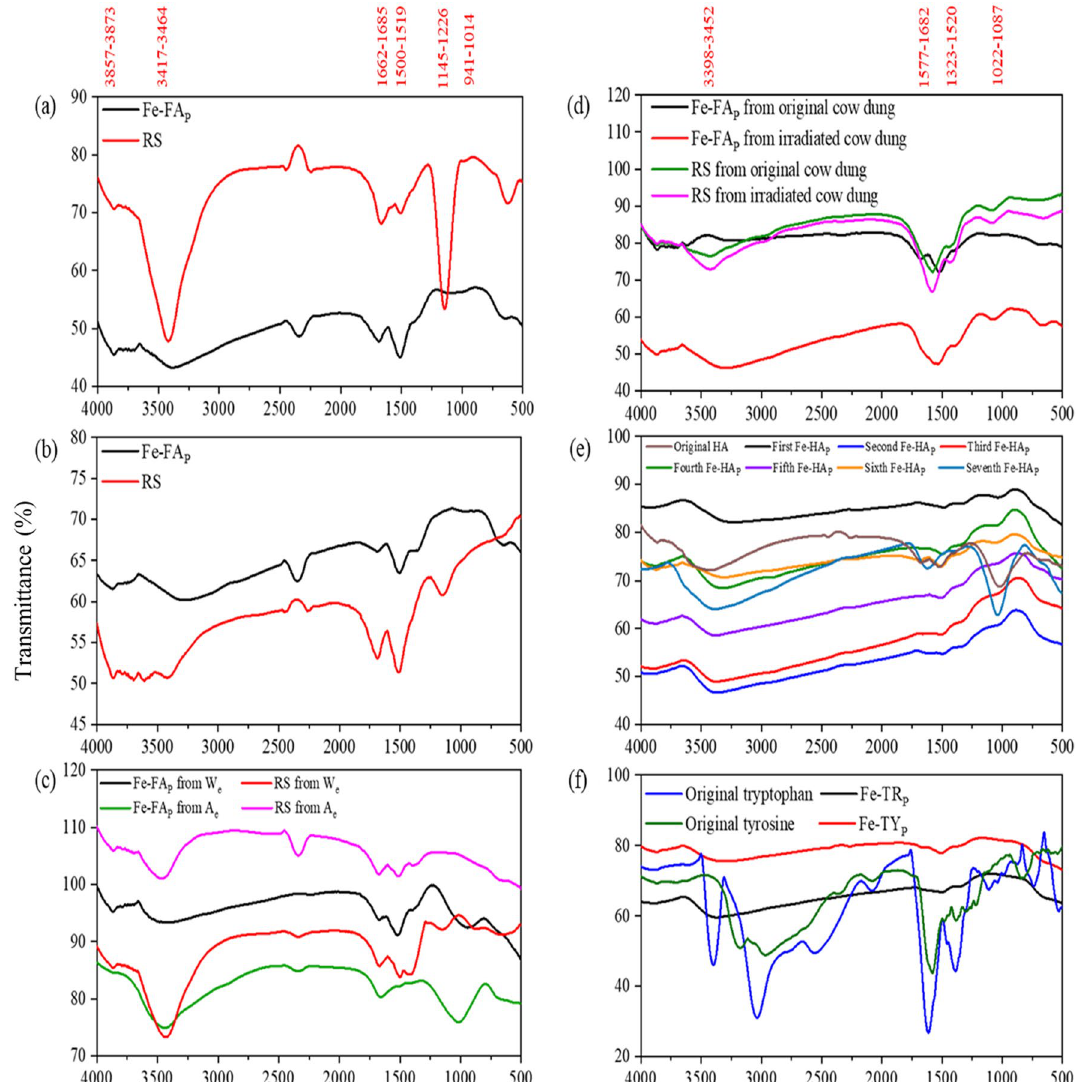
Figure 4. FTIR spectra of Fe ‒ fulvic acid precipitates (Fe ‒ FA P ) and remaining solution (RS) after the final precipitation step of Fe ‒ FA P from Baigou River ( a ), Jingye Lake ( b ), soil We and Ae ( c ), original and irradiated cow dung samples ( d ), original soil humic acids (HA) and Fe ‒ HA precipitates (Fe ‒ HA P ) ( e ), and Tryptophan (TR) and Tyrosine (TY) and their FeCl 3 precipitates (Fe ‒ TR P and Fe ‒ TY P ) ( f The N% features the lowest values in Fe-FA P from river, lake and soil W e and the highest ones in the original HA and Fe-FA P from cow dung, whereas in Fe-FA P from irradiated cow dung sample, Fe-HA P , Fe-Tryptophan P and Fe-Tyrosine P the N% is lower than that in the corresponding unreacted sample. The high N% in the original cow dung sample may be attributed to the high content of Tyrosine 65 that declines upon sunlight exposure of cow dung. The C/N ratio is relatively low in Fe-FA P from soil A e , and much higher in irradiated cow dung, Fe-HA P , Fe-Tryptophan P and Fe-Tyrosine P than in the corresponding not-irradiated cow dung, soil HA, Tryptophan and Tyrosine. Finally, the S% results ≤ 1.0% in most Fe-FA P samples and only in the Fe 3+ precipitate from irradiated cow dung sample reaches the maximum value of 1.0%. As expected from the corresponding S%, the C/S ratios of Fe-FA P from cow dung, soil A e , and river and lake waters are very high, and those of the remaining samples quite low. Thus, the Fe-FA P fractions isolated in each step feature a different elemental composition, which is sup- ported by the blue-shift of FA peaks in the RS after each precipitation step (Fig. 2), and confirms previous FTICR-MS studies 78–80 . Further studies on the elemental composition of Fe-FA P isolated in each step will be necessary to achieve a better understanding of FA components and their biogeochemical transformation in specific ecosystems. FTIR spectra. The most relevant infrared absorption features and their differences (Fig. 4) are summarized below. ( i ) The presence of two weak bands at 3884–3857 cm −1 in Fe-FA P and remaining supernatants from river